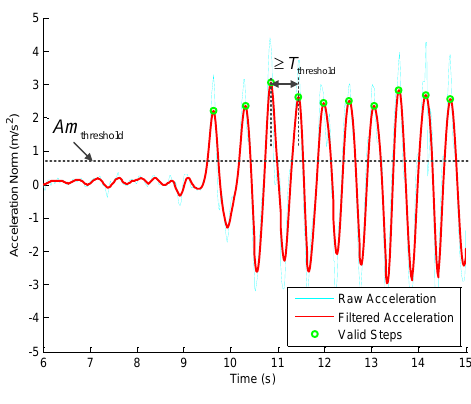
Figure 3. Results of step